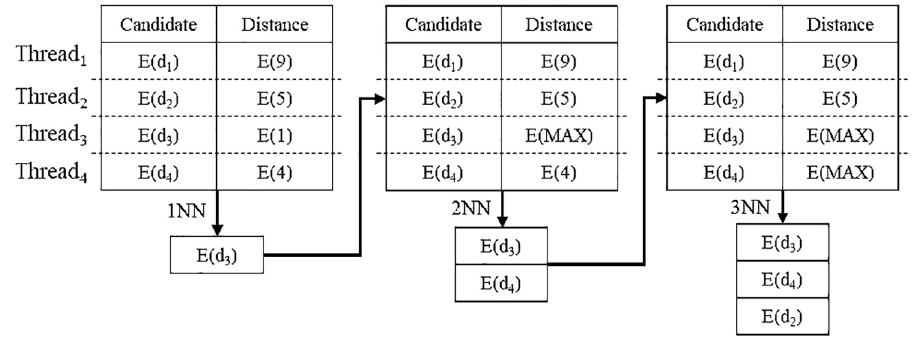
Fig 6. Example of kNN search